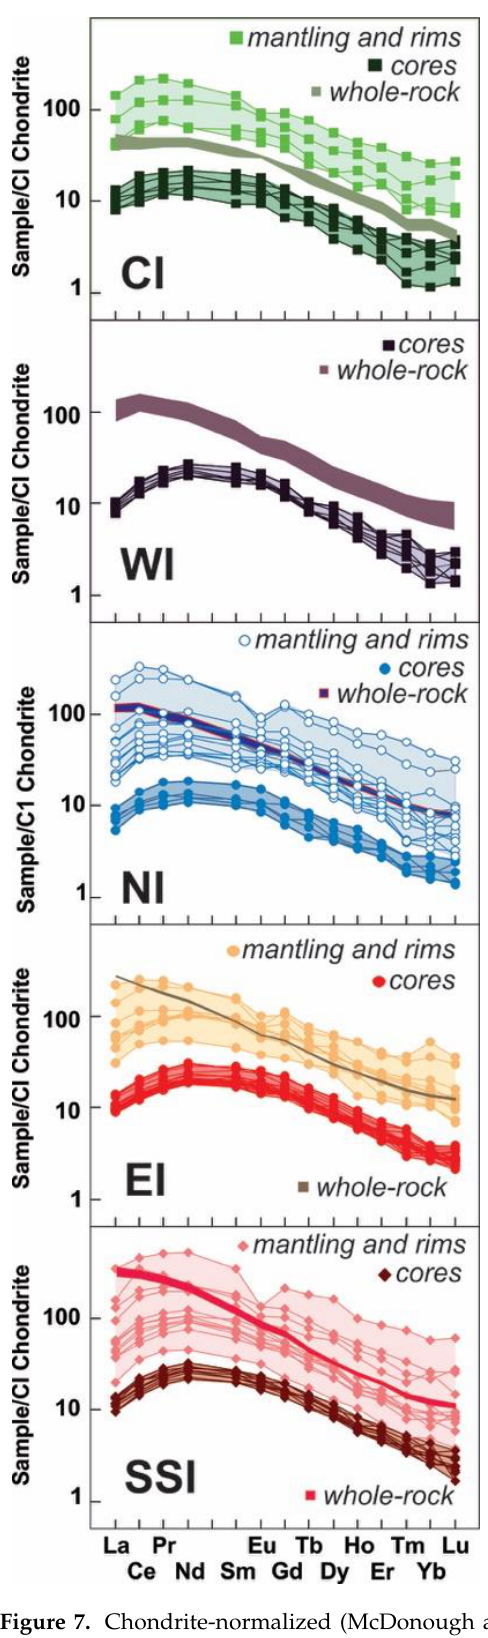
Figure 7. Chondrite-normalized (McDonough and Sun, 1995) [57] REE distribution diagram of clinopyroxenes from the Ponte Nova mafic – ultramafic alkaline massif. Fields of whole-rock compositions were made after compilation from Azzone et al., (2016; 2020 — see Supplementary Material B) [41,48].